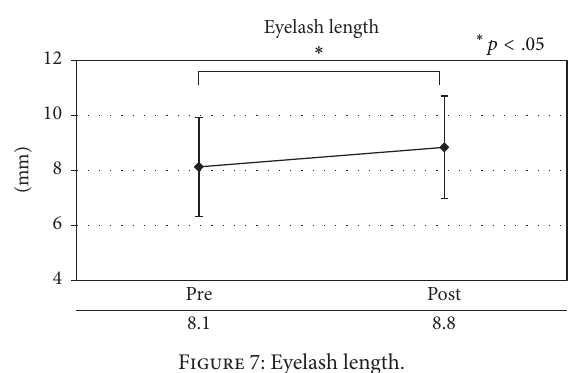
Figure 7: Eyelash length.